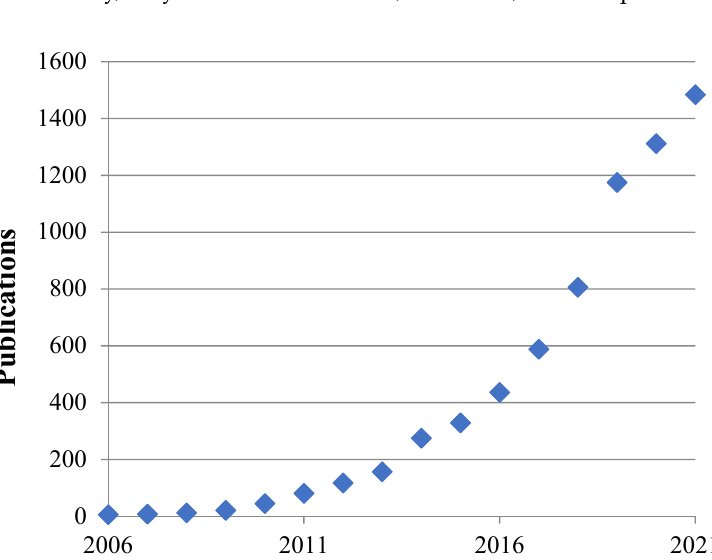
Figure 1. Growth dynamics of the number of research papers on the structure, properties, and applications of the materials comprising natural nano- and micro-fibers. Data obtained from Scopus using the following search parameters “TITLE-ABS-KEY” with keywords «Nanocellulose or micro-cellulose» on 28 February 2022.